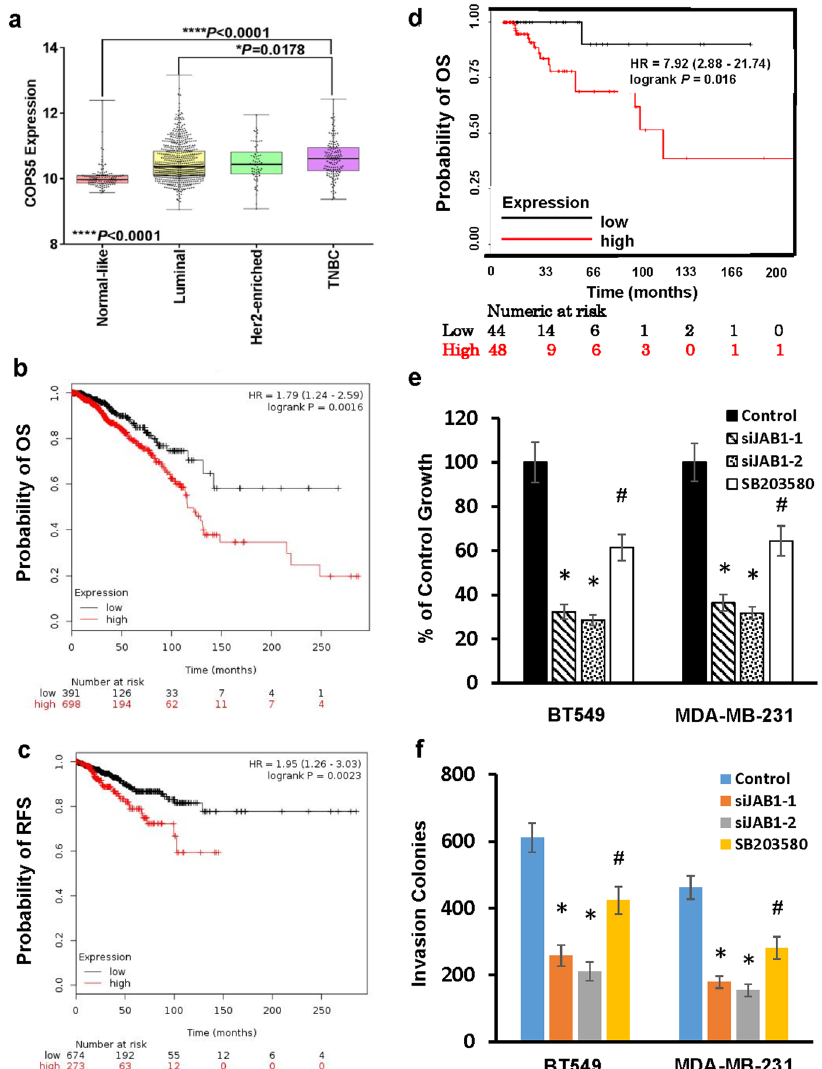
inversely correlated with breast cancer patient overall ( b ) and recurrence-free survival ( c ). d JAB1 expression is inversely correlated with TNBC patient overall survival. e , f BT549 or MDA-MB-231 cells were treated with 30 nM JAB1 siRNAs (siJAB1-1, siJAB1-2), scrambled siRNA control